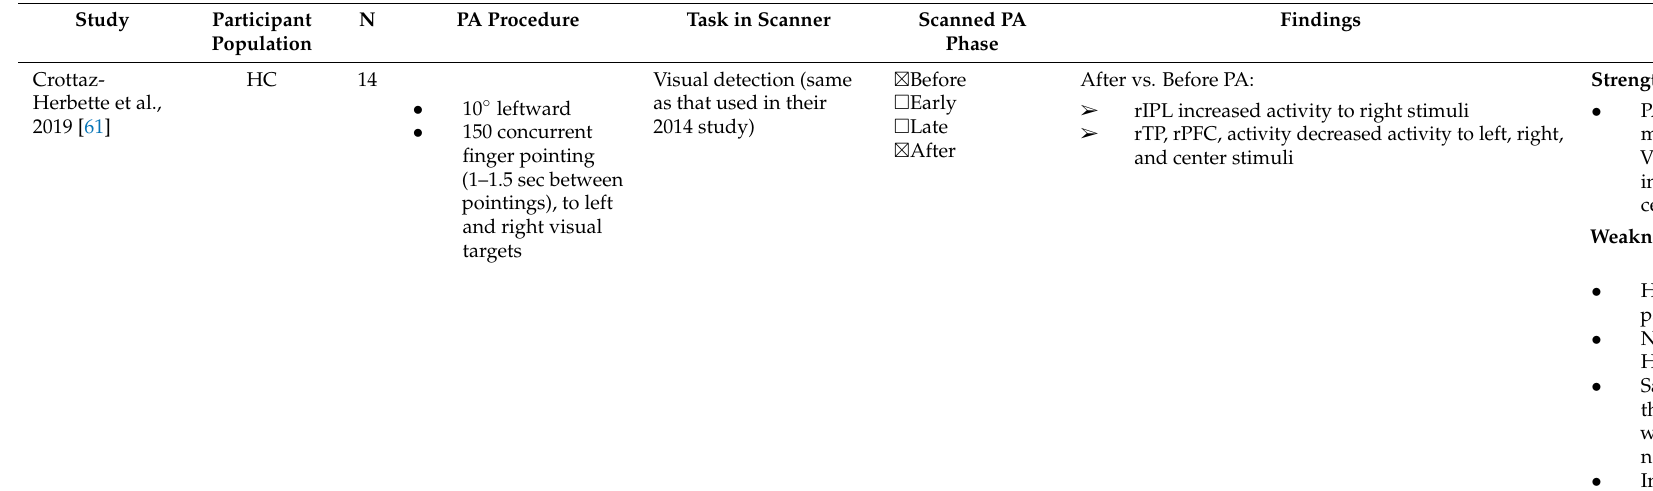
Meta-Analysis 1: Before and after PA in Healthy